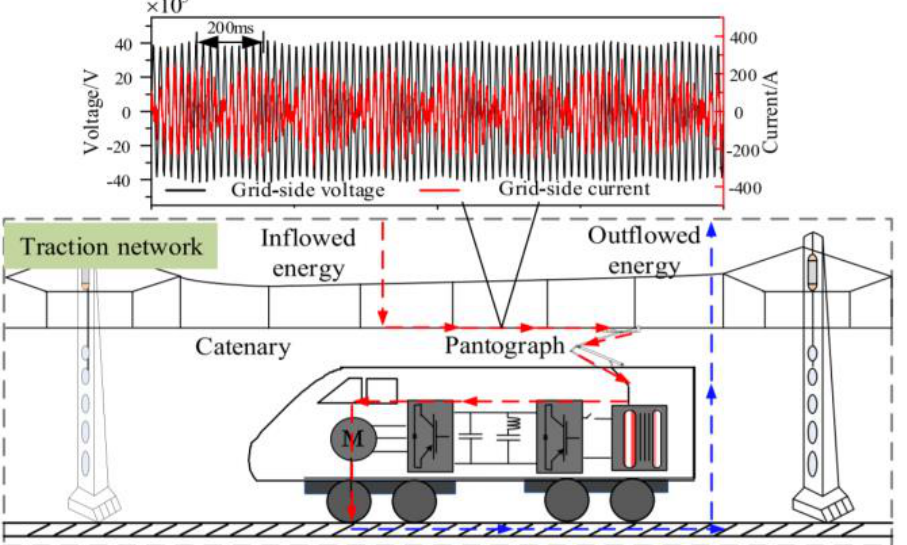
Figure Figure 4. The overhead catenary voltage and current with low frequency oscillation (LFO) phenomenon [59,60].